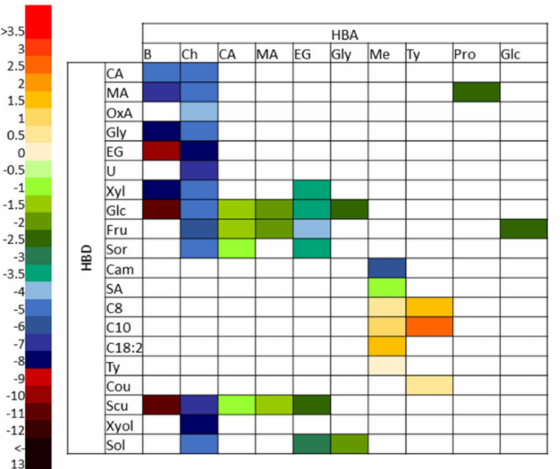
Figure 2. Predicted ln γ solutes in DES at 60 ◦ C using COSMO-RS. Labels: CA–citric acid; MA–malic